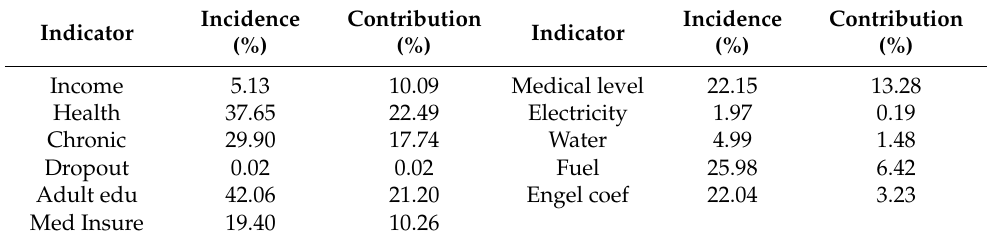
Table 4. Poverty incidence and poverty contribution rate by indicator